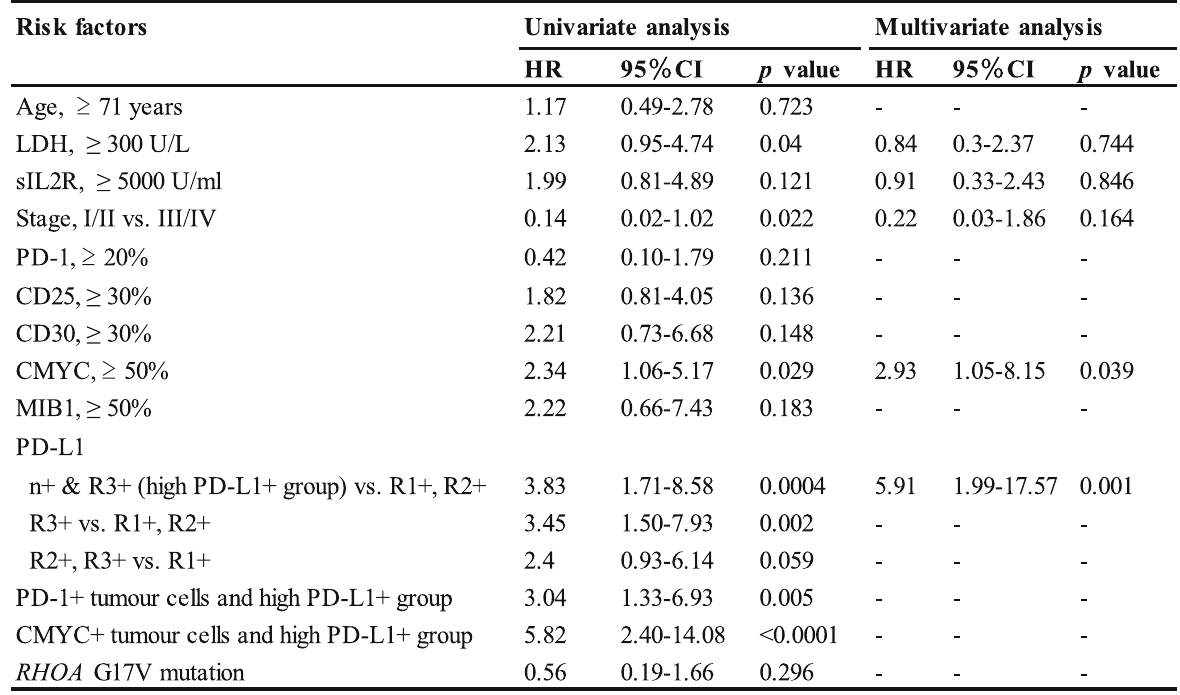
Table 2 Univariate and multivariate analyses of risk factors for overall survival in examined 64 patients with TFH+peripheral T-cell